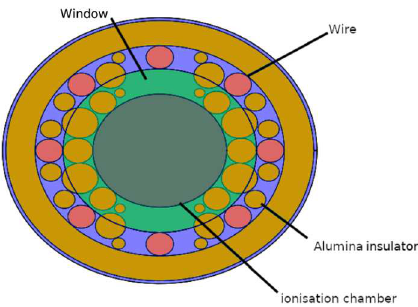
Fig. 15. Top view in transparency of the approximated mpfd geometry drawn by COSICAF. Alumina casing on the side of the ionisation chamber is approximated by cylinder shells and rods (in yellow) while electrodes are depicted in red.